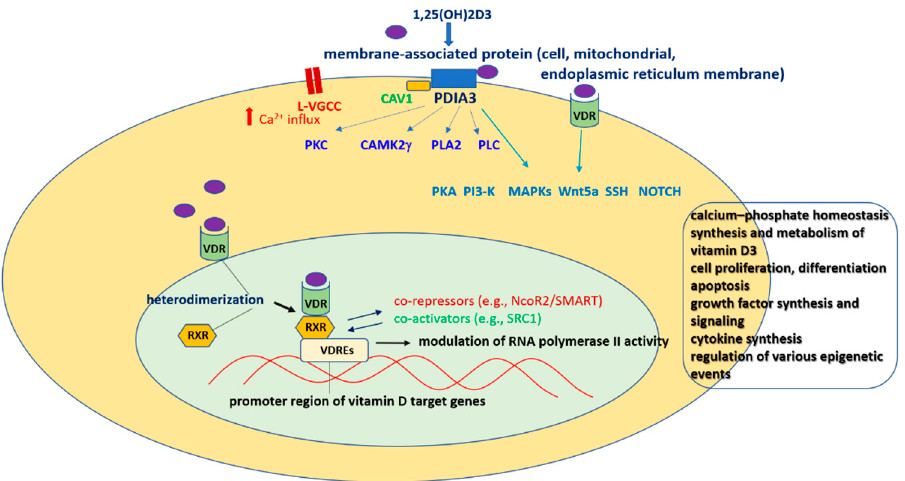
Figure 1. Vitamin D3 binding sites and signaling pathways. 1,25(OH)2D3—active form of